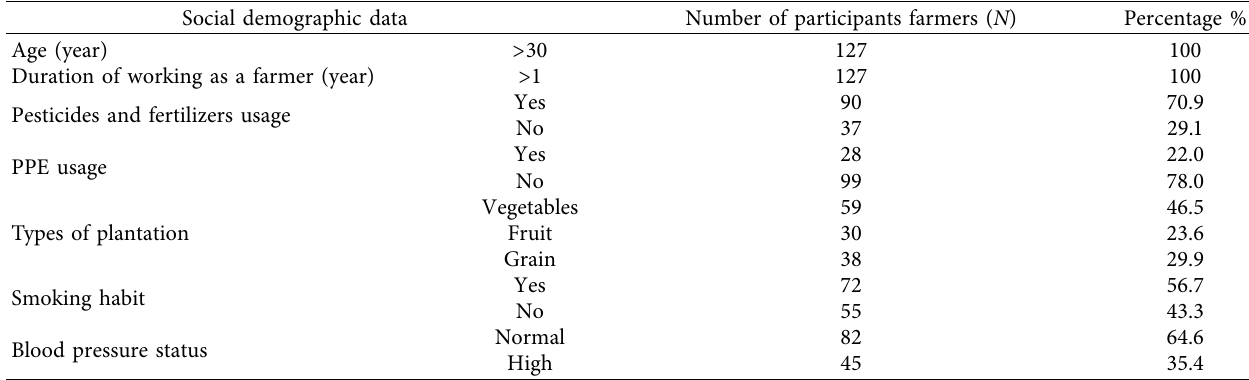
Table 4: Description of the participating farmers.